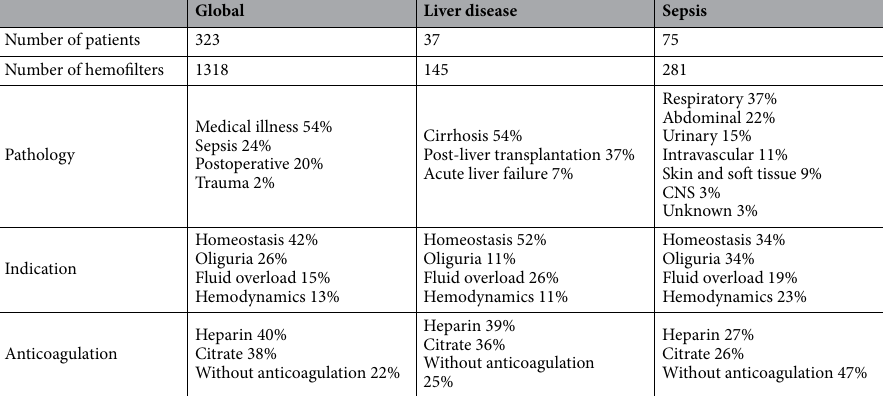
Table 3. General characteristics of CRRT by pathology subgroup in our